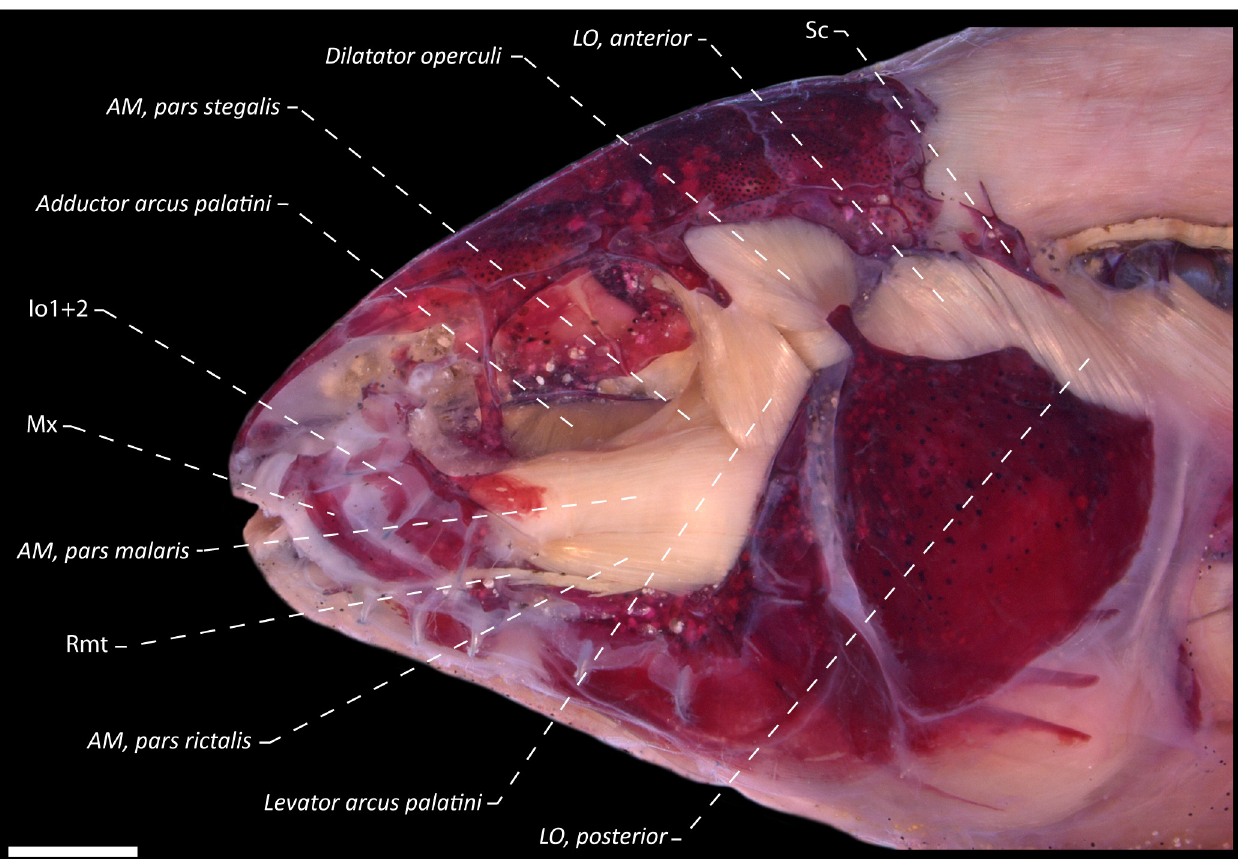
Fig 8. Lateral view of the dorsolateral head muscles of the Eigenmannia sirius , MCP 41099, paratype, 97.6 mm L EA . AM = adductor mandibulae ; Io = infraorbitals; LO = levator operculi ; Mx = maxillary bone; Rmt = ramus mandibularis trigeminus ; Sc = supracleithrum